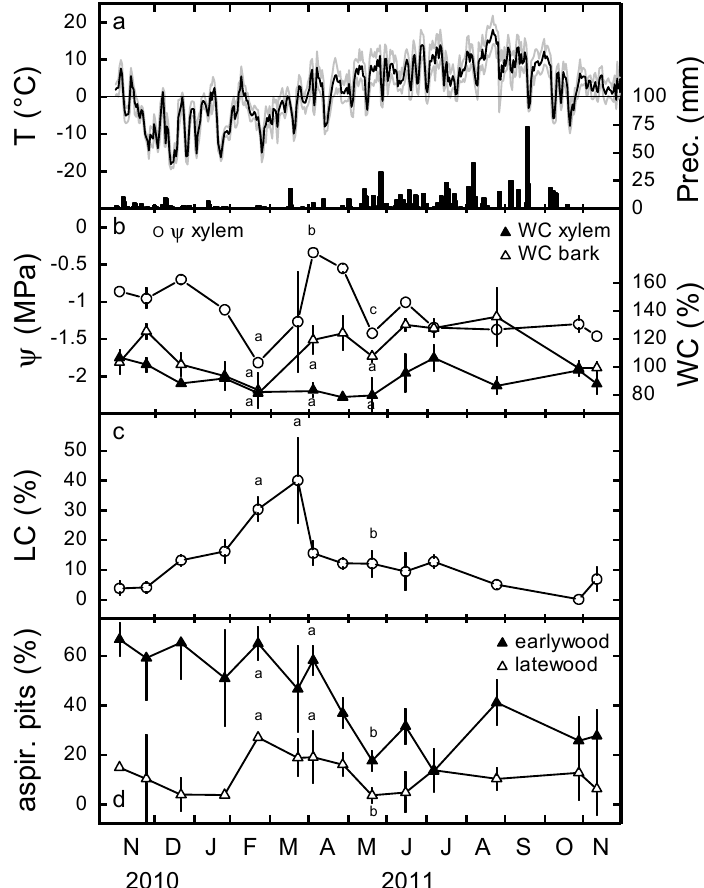
Figure 3. Climate, course of water potential and content, loss of conductivity, and pit aspiration. ( a ) Air temperatures (T; daily minimum, mean, and maximum) and daily sum of precipitation (prec.) from Mt. Patscherkofel (2.252 m provided by ZAMG Zentralanstalt für Meteorologie und Geodynamik, Austria). ( b ) Water potential ( Ψ ) and water content in stem bark and xylem. ( c ) Loss of conductivity in branch xylem (LC). ( d ) Proportion of aspirated pits (asp. pits) in earlywood and latewood. Mean ± SE. Different letters indicate significant differences measurements on 22 February, 19 May, and the sampling date of the highest values within this period.